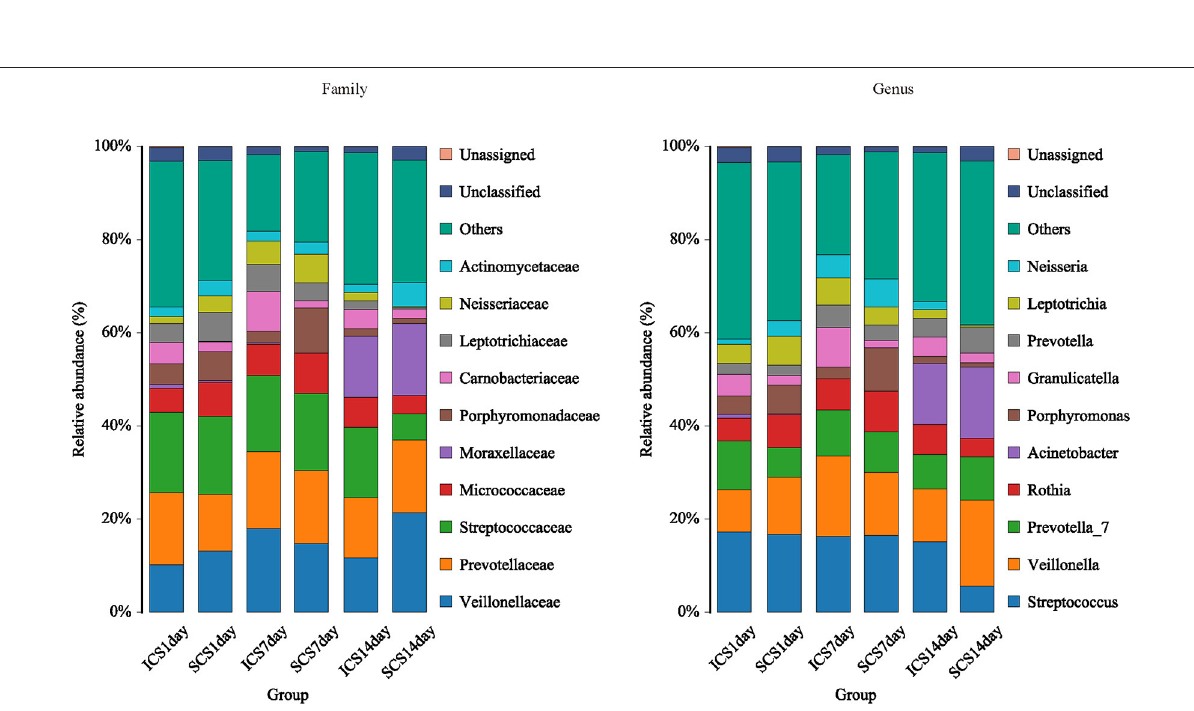
FIGURE 3 | Species distribution of each group. Species distribution of bacteria in each group (family and genus level). Community composition based on 16S rRNA gene fragment sequences in sputum samples. Bars represent the relative abundances of the most abundant families ( > 5% in one group). The remaining families are subsumed as